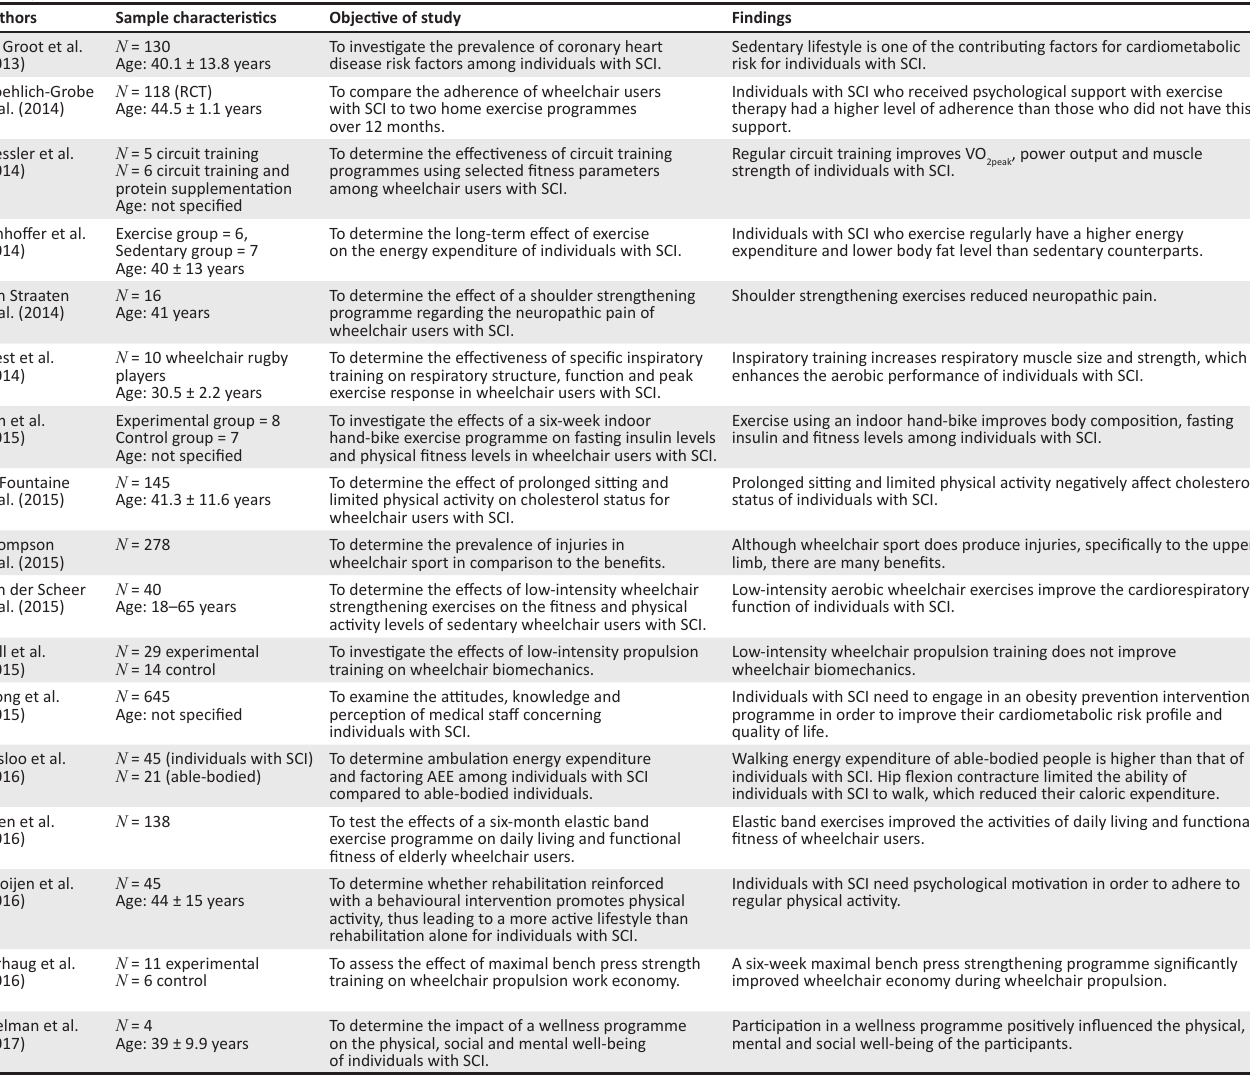
TABLE 3: Chronological review of literature, identifying the cardiometabolic risk profiles and benefits of exercise for wheelchair users with spinal cord injuries (2013–2017) ( n = 17).